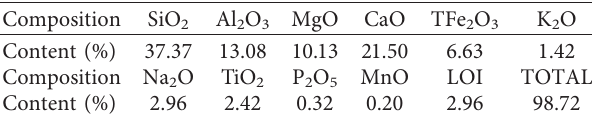
Table 1: Chemical composition of the examined